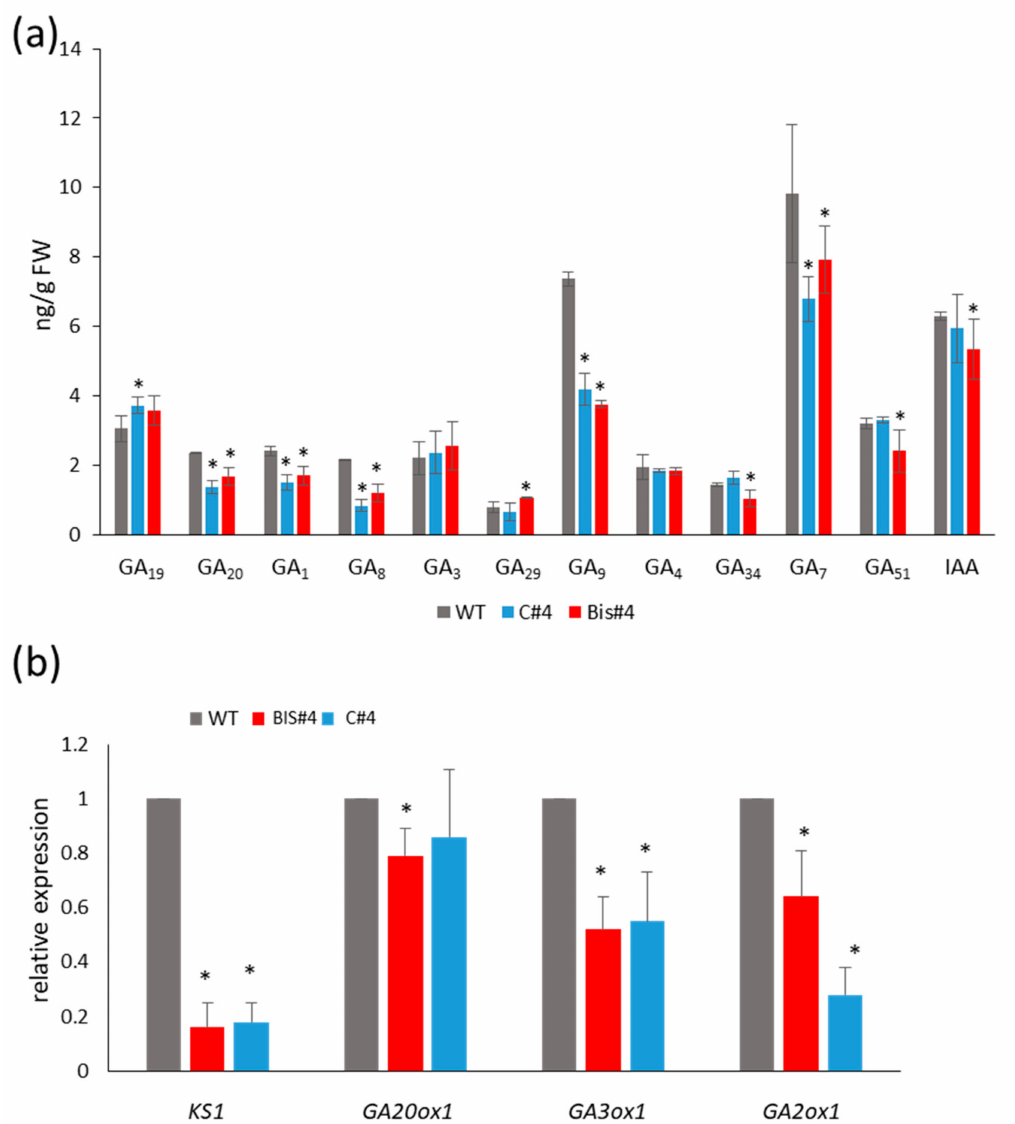
Figure 6. GA content and expression of GA biosynthetic genes in AtCuAO δ mutants compared to WT. ( a ) Quantitative analysis of endogenous gibberellins by GC-MS / MS extracted from 2-week-old seedlings. ( b ) Real-time PCR of GA biosynthetic genes, KS1 , GA20ox-1 , GA3ox-1 , and GA2-ox-1 . n = 3; means ± SE; asterisks indicate significant di ff erences to WT ( p ≤ 0.05), based on a Student t